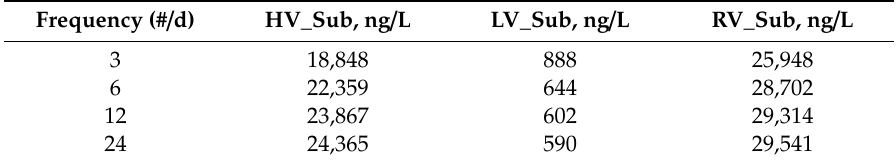
Table 7. Average concentrations of the three substances in the case of volume proportional